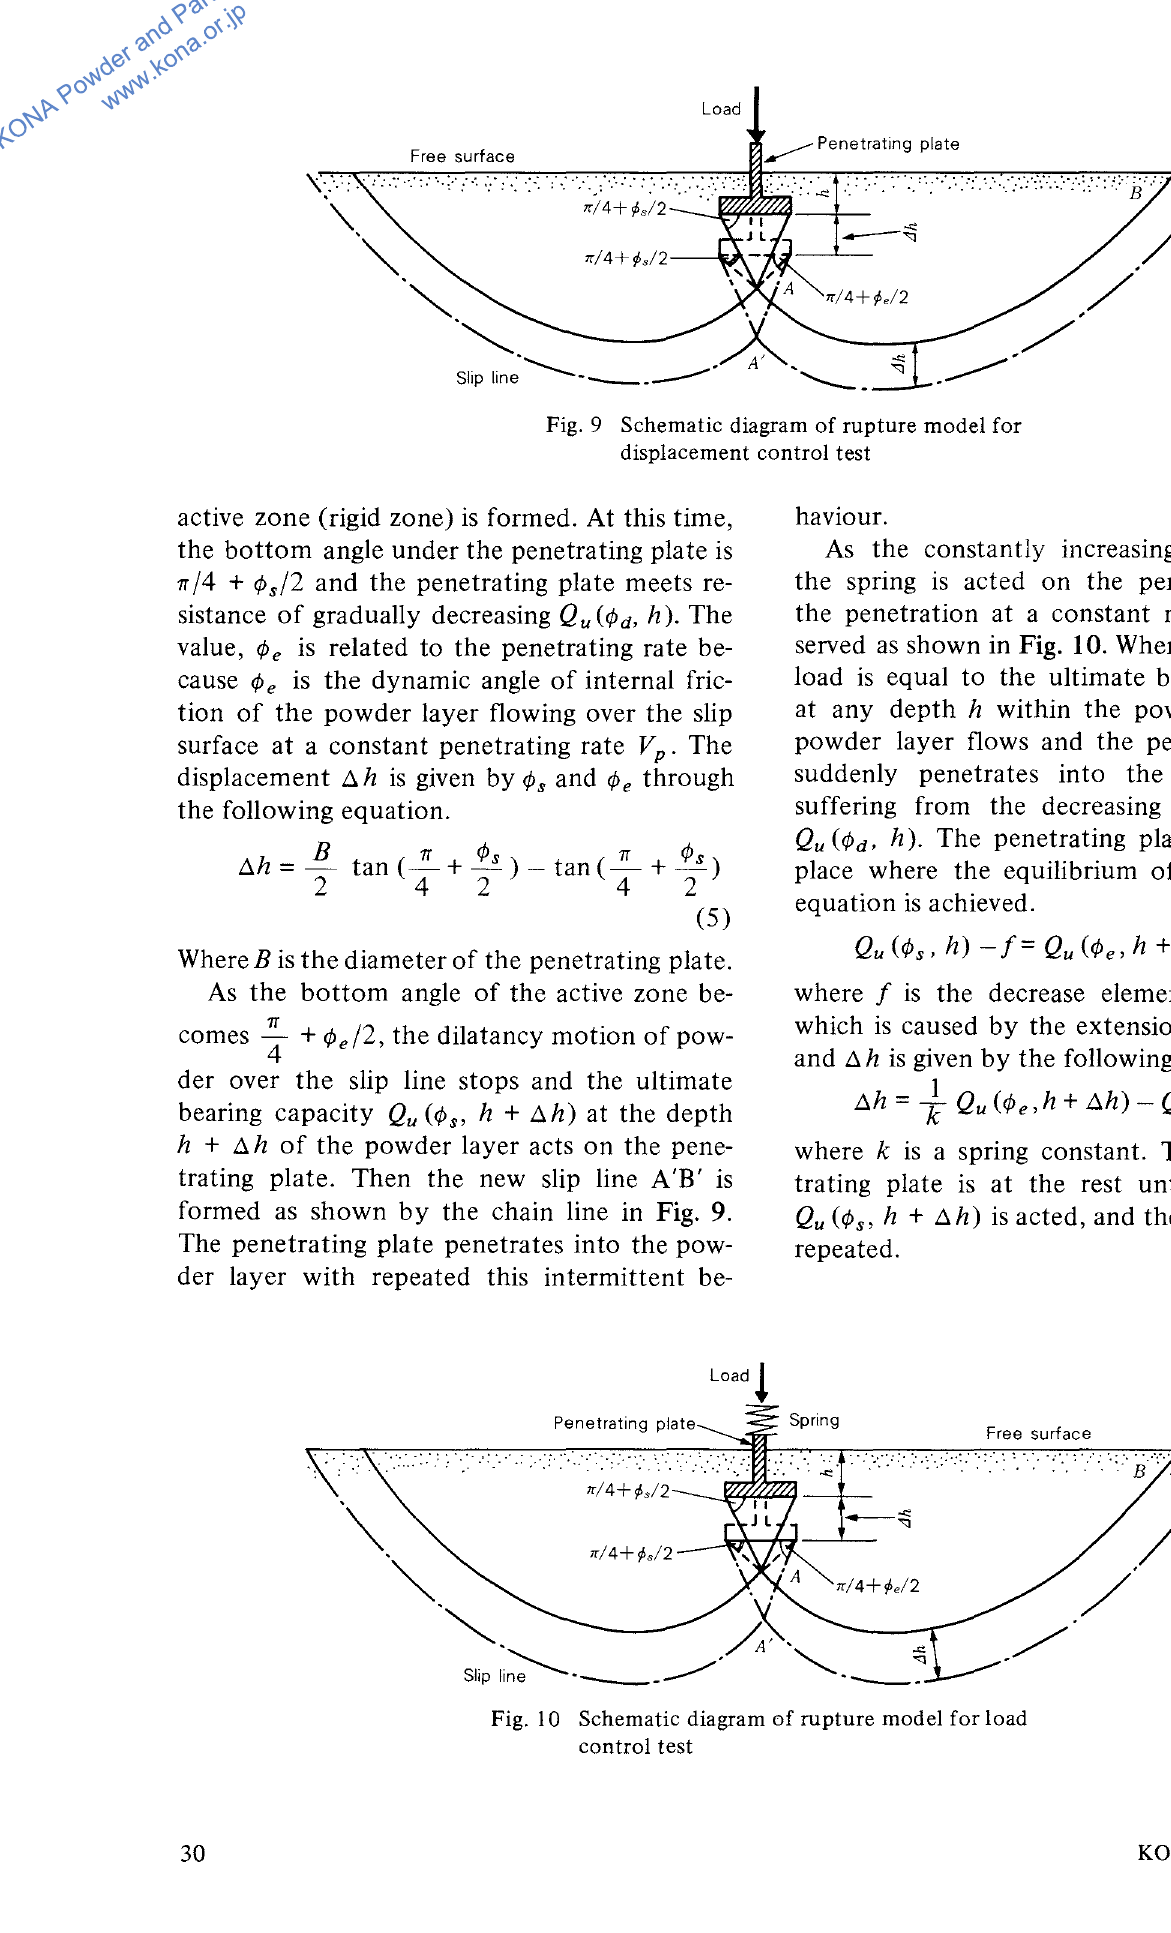
Fig. I 0 Schematic diagram of rupture model for load control